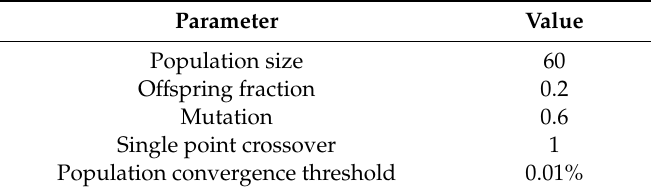
Table 5. GA parameters; the detailed description of the parameters can be found in [50].